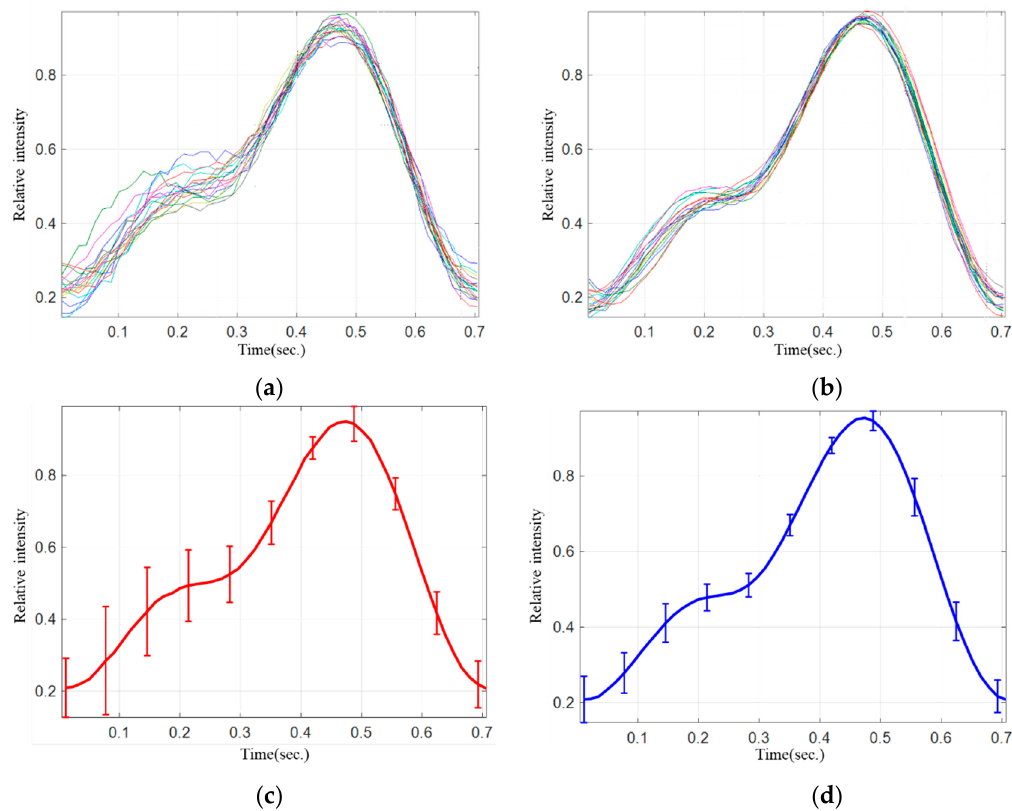
Figure 8. Waveform and variation of the PPG signals: ( a ) and ( c ) are measured by the reference SW-PPG sensing device, ( b ) and ( d ) measured by the MW-PPG sensing device developed.